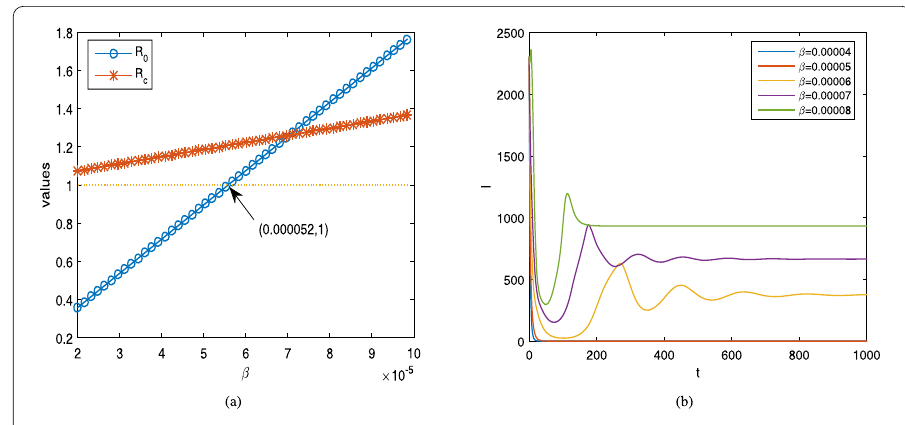
Figure 6 Simulations for system (2.1) with respect to parameter β . ( a ) R 0 , R c in terms of different β ; (cid:25) ( b ) (cid:2) I ( x , t ) dx in terms of different